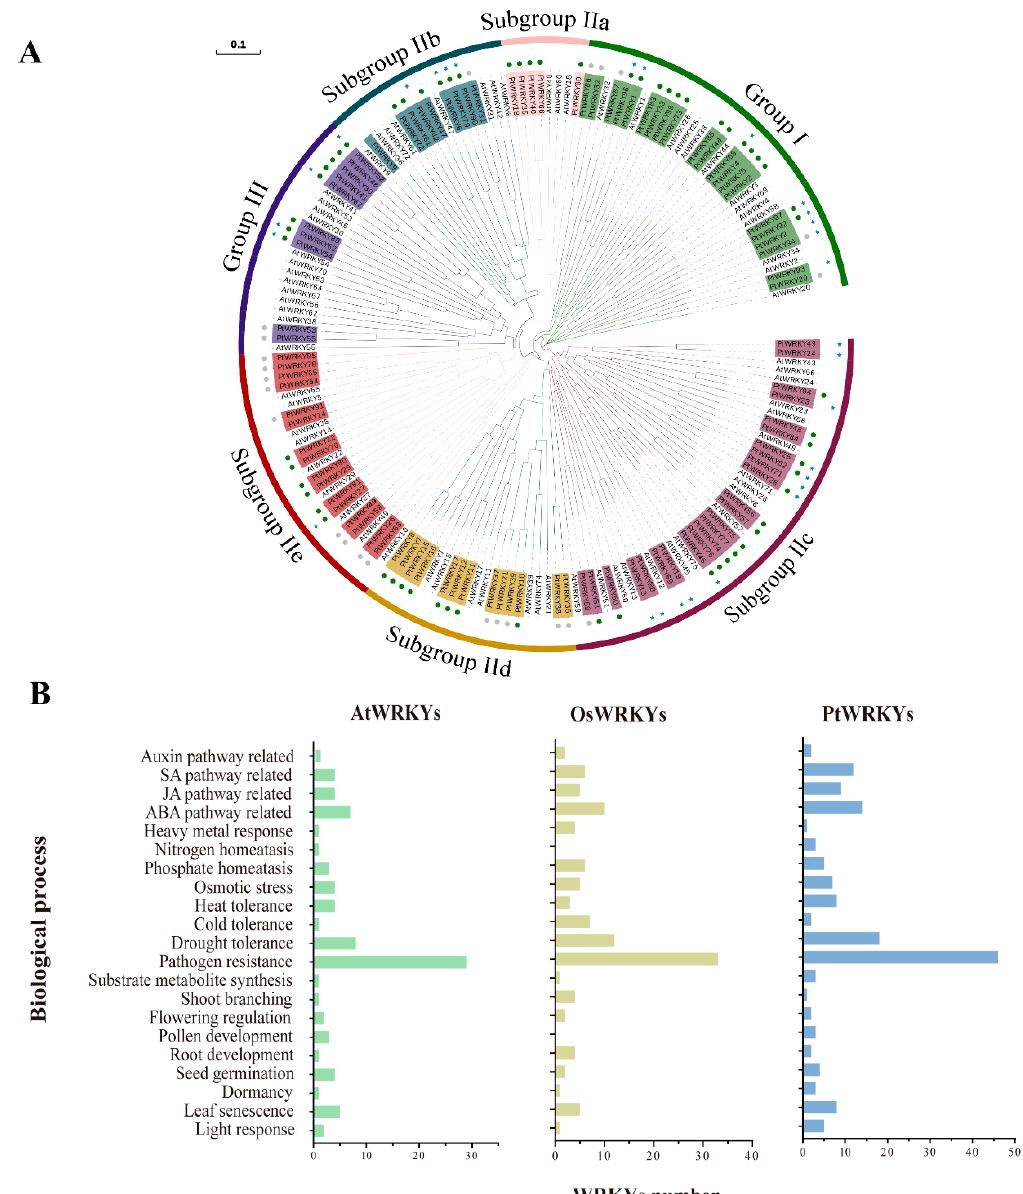
Figure 5. Functional annotations of WRKY TFs. Polygenetic tree WRKY TFs in poplar and Arabidopsis ( A ). Different colors were used to mark the phylogenetic branches of WRKY transcription factors in different subgroups. The protein names of the different subgroups of PtWRKYs are highlighted using a background of different colors, and AtWRKYs is not highlighted. Circles and stars following the protein name indicate the predicted physiological function of the protein, respectively: green circles indicate stress response function, gray circles indicate unknown function, and blue stars indicate growth and development regulation function. Previous reported functions of WRKY TFs in Arabidopsis and rice and putative functions of WRKY TFs in poplar (B).